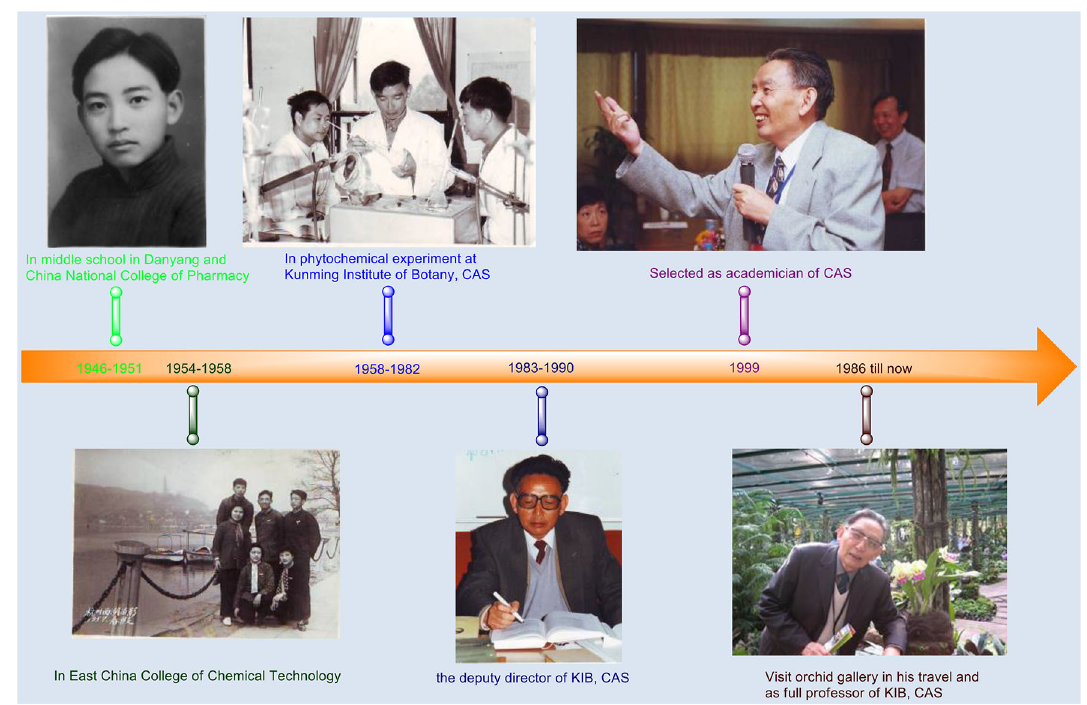
Fig. 1 Timeline of Prof. Zhou Jun from 1946 to present